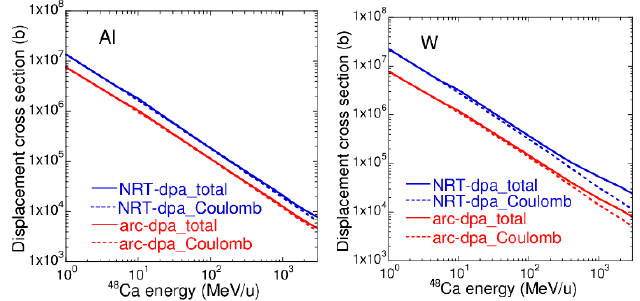
Figure 2 . NRT-dpa cross sections for 48 Ca irradiation on aluminium and tungsten.